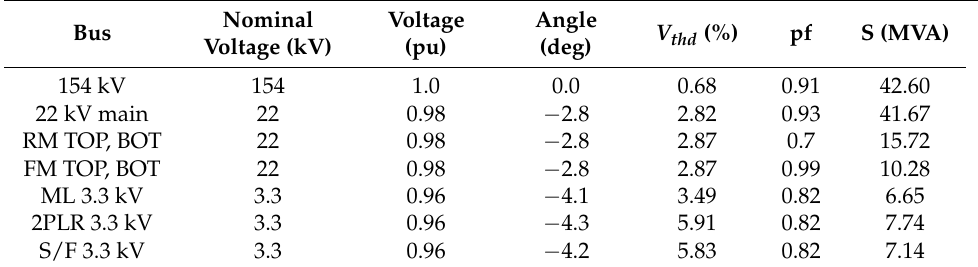
Table 8. ESA calculation results for load flow, V thd , and power factors with filter.